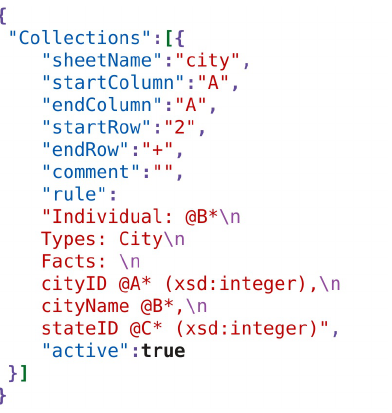
Figure 9. An example of transformation rules from the Cities